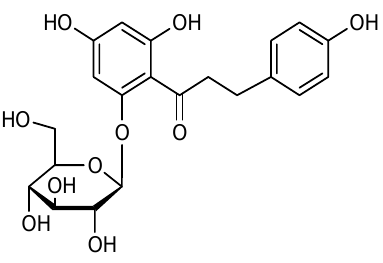
Figure 1 . Chemical structure of